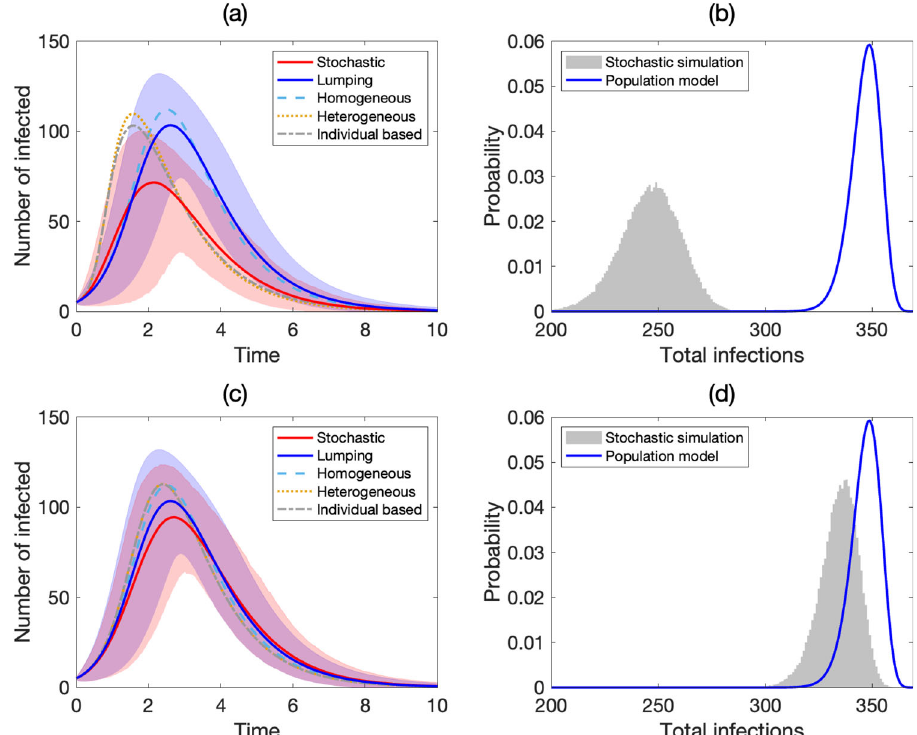
Fig. 2 Comparison of stochastic simulations and approximate lumping of the susceptible – infected – recovered (SIR) model of epidemics. a Illustrates the evolution of the mean number of infected vertices from 3000 stochastic simulations (thick red line) and the approximate lumping (thick blue line) for the SIR model on the Haselmere 1m network. The red and blue shading illustrate the 90-percentile of the corresponding distributions. The light blue dash, yellow dot, and grey dash-dot lines indicate the mean number of infected vertices for homogeneous, heterogeneous and individual based mean- fi eld approximations respectively. b Illustrates the probability distribution of the total number of infections computed from 100,000 stochastic simulations, each run until t = 1000 (grey shading). The corresponding probability distribution computed from the approximate lumping is illustrated in blue. c and d Illustrate the same as a and b , respectively, but for an Erd ő s – Rényi graph with N = 369 vertices and mean degree z =